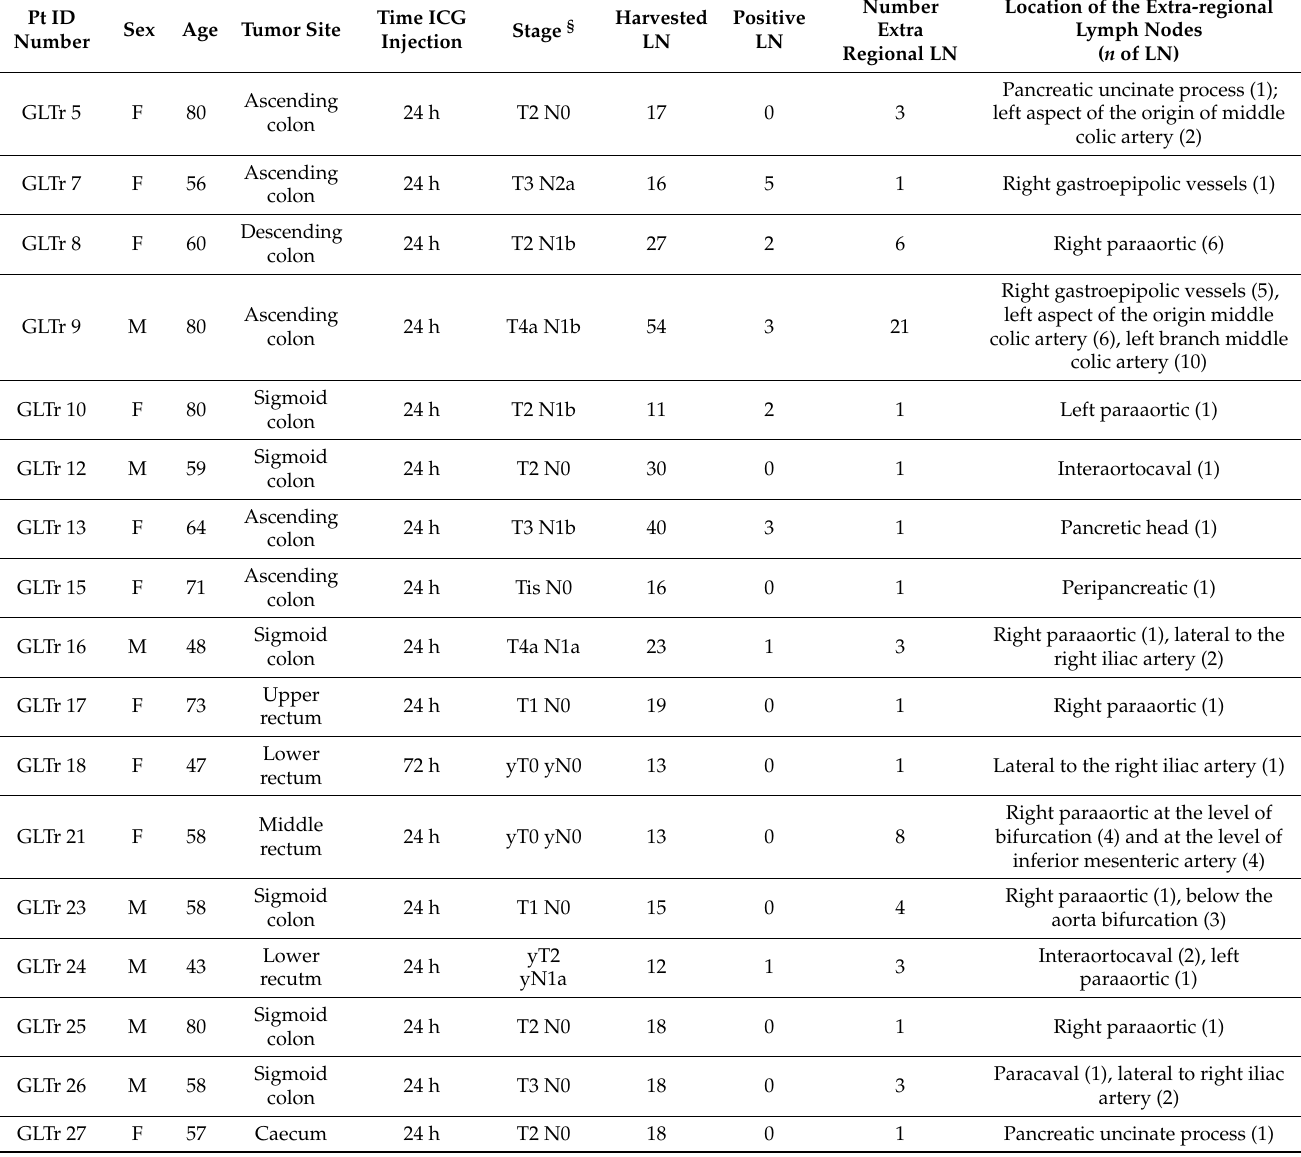
Table 3. Sites of fluorescent nodes outside the standard lymphatic